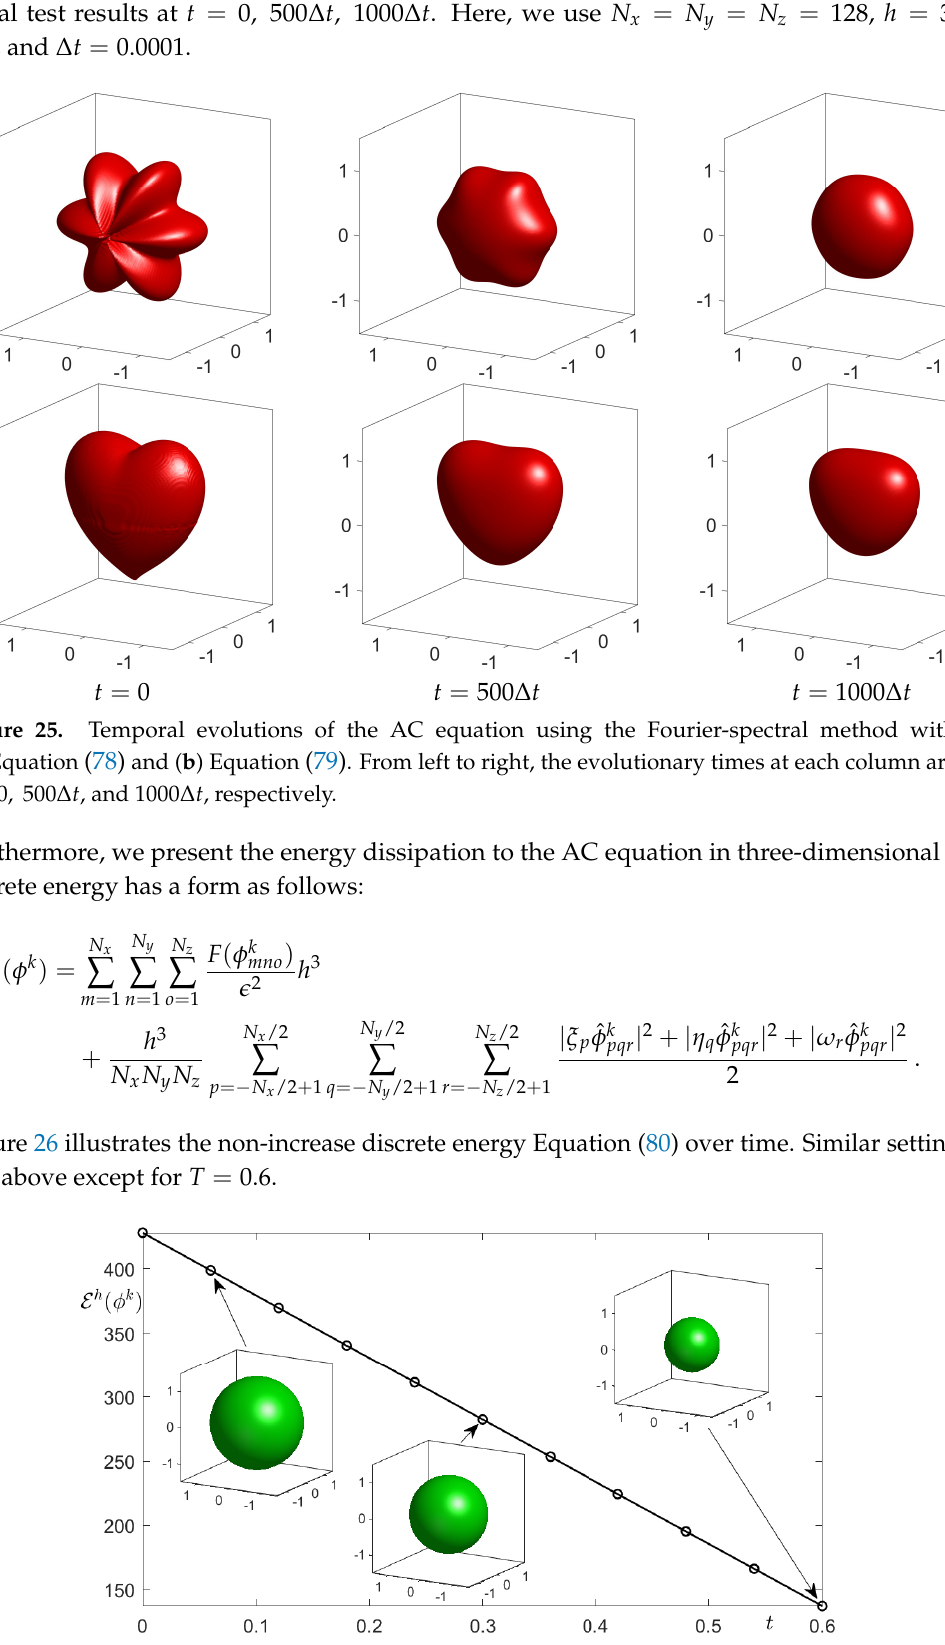
Figure 26. Energy dissipation over time to the AC equation with the initial condition (77)